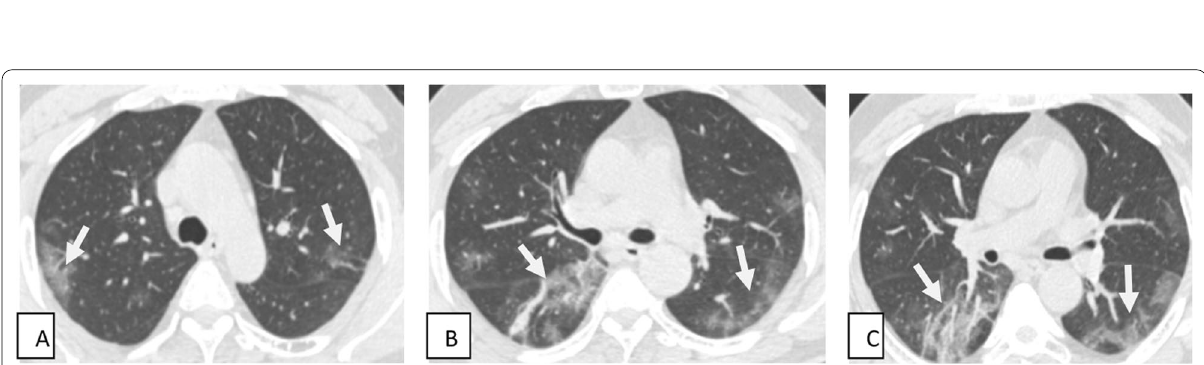
Fig. 5 Male patient aged 54 years with cough, fever and myalgia. Axial ( A – C ) CT images show bilateral multifocal areas of ground‑glass density (white arrows) seen at both lung fields with peripheral subpleural predominance (mild severity)